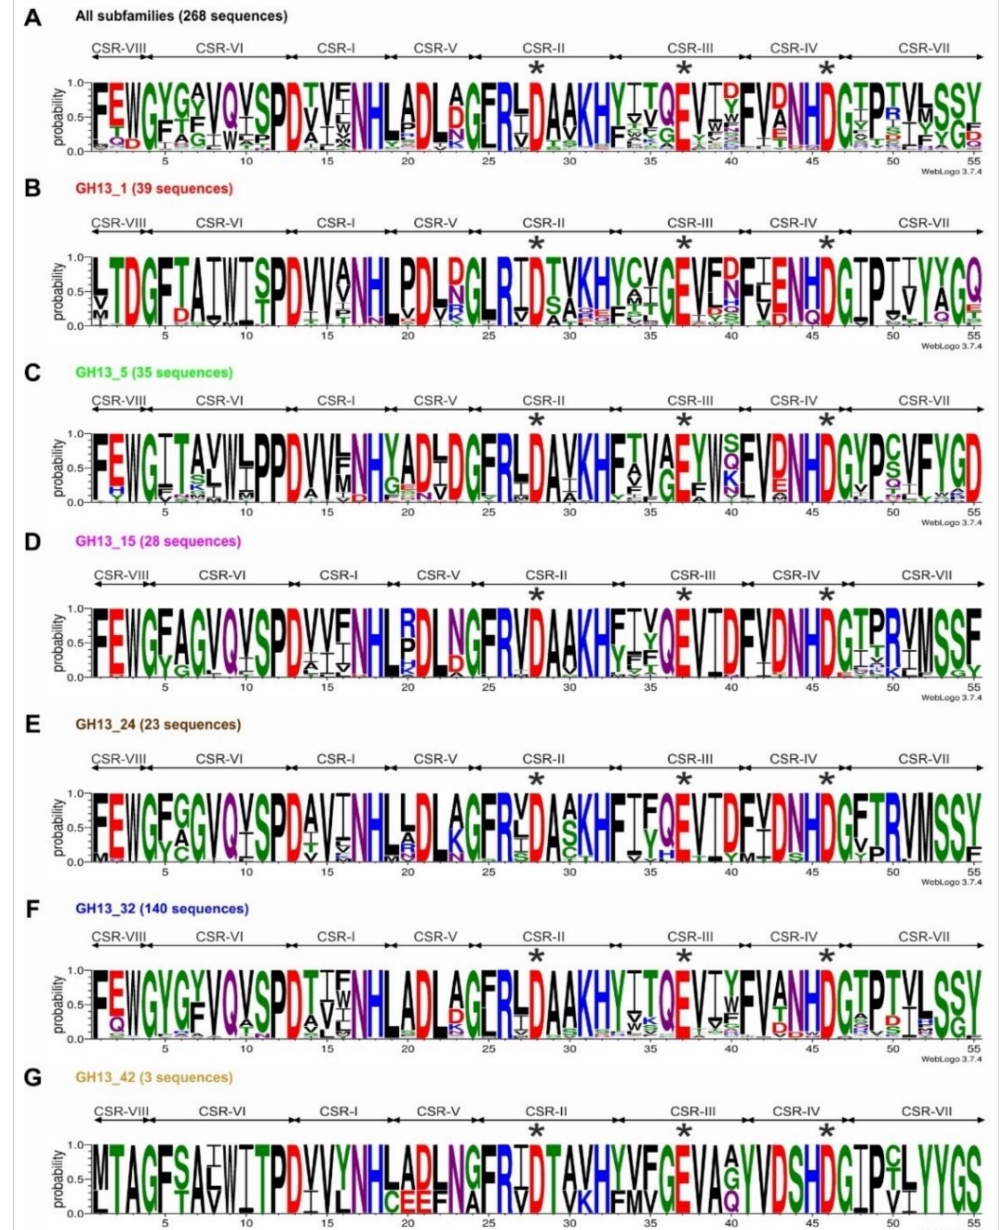
Figure 1. Sequence logos of α -amylases from studied GH13 subfamilies. Logos for ( A ) all the six studied subfamilies (268 sequences); ( B ) subfamily GH13_1 (39 sequences); ( C ) subfamily GH13_5 (35 sequences); ( D ) G13_15 (28 sequences); ( E ) subfamily GH13_24 (23 sequences); ( F ) subfamily GH13_32 (140 sequences); and ( G ) G13_42 (3 sequences). CSR-I, residues 13–18; CSR-II, residues 24–32; CSR-III, residues 33–40; CSR-IV, residues 41–46; CSR-V, residues 19–23; CSR-VI, residues 4–12; CSR-VII, residues 47–55; CSR-VIII, residues 1–3. The catalytic triad, i.e., the catalytic nucleophile (No. 28, aspartic acid in CSR-II), the proton donor (No. 37, glutamic acid in CSR-III) and the transition-state stabilizer (No. 46, aspartic acid in CSR-IV) are indicated by